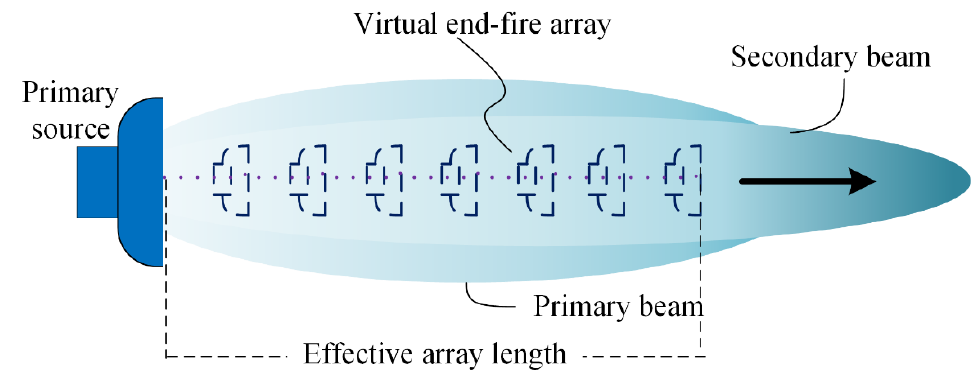
Figure 1. Generation of the secondary beam through the PAA.